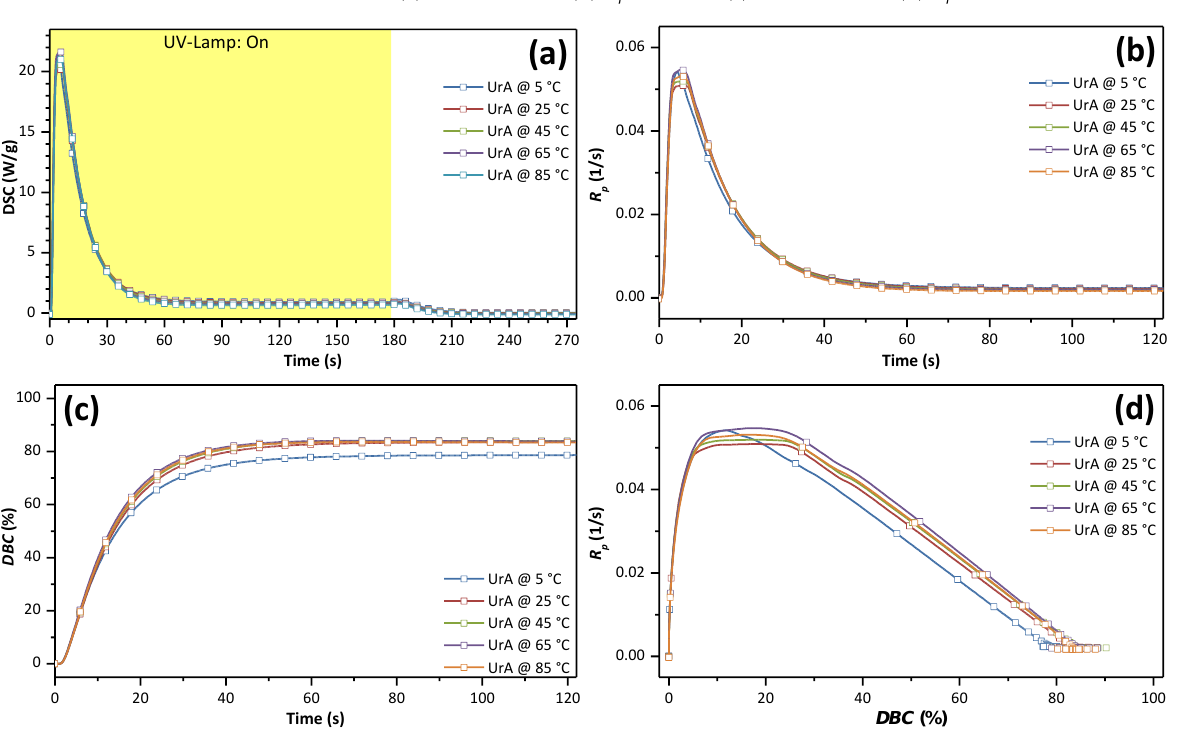
Figure 3. Photo-curing rates and conversions for UrA containing TPOL (1 wt.%) under N 2 atmosphere at different temperatures obtained from photo-DSC data. The intensity of the UV lamp was 1 W/m 2